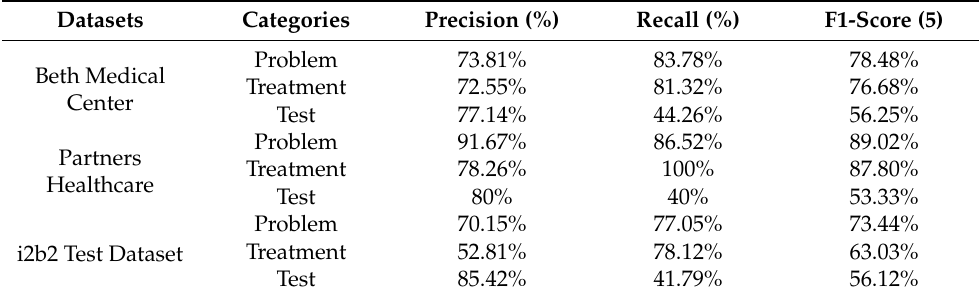
Table A3. Individual concepts performance measures for the Beth, Partner, and Test datasets, employing exact-plus-approximate (hybridized) term matching to